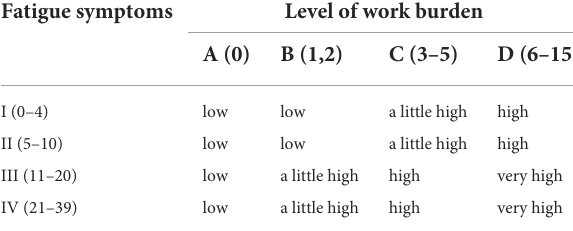
TABLE 1 Classification of work-related accumulative fatigue. Fatigue